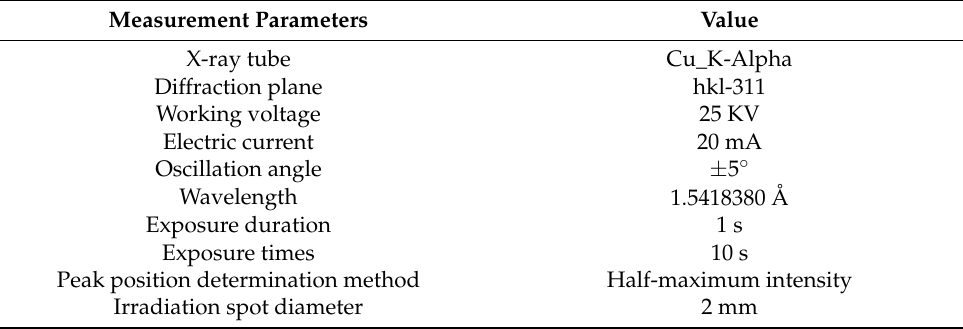
Table 3. X-ray stress measurement parameters applied in this work.